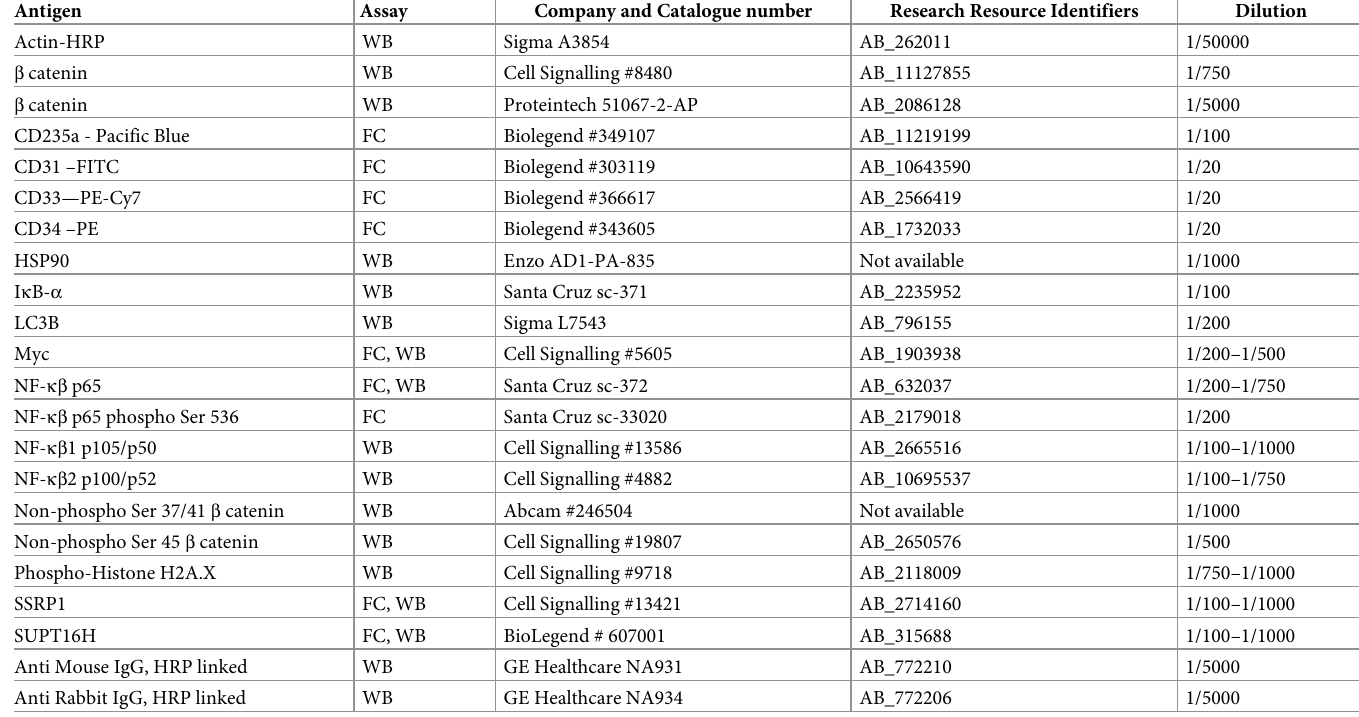
Table 1. Antibodies used in the study.